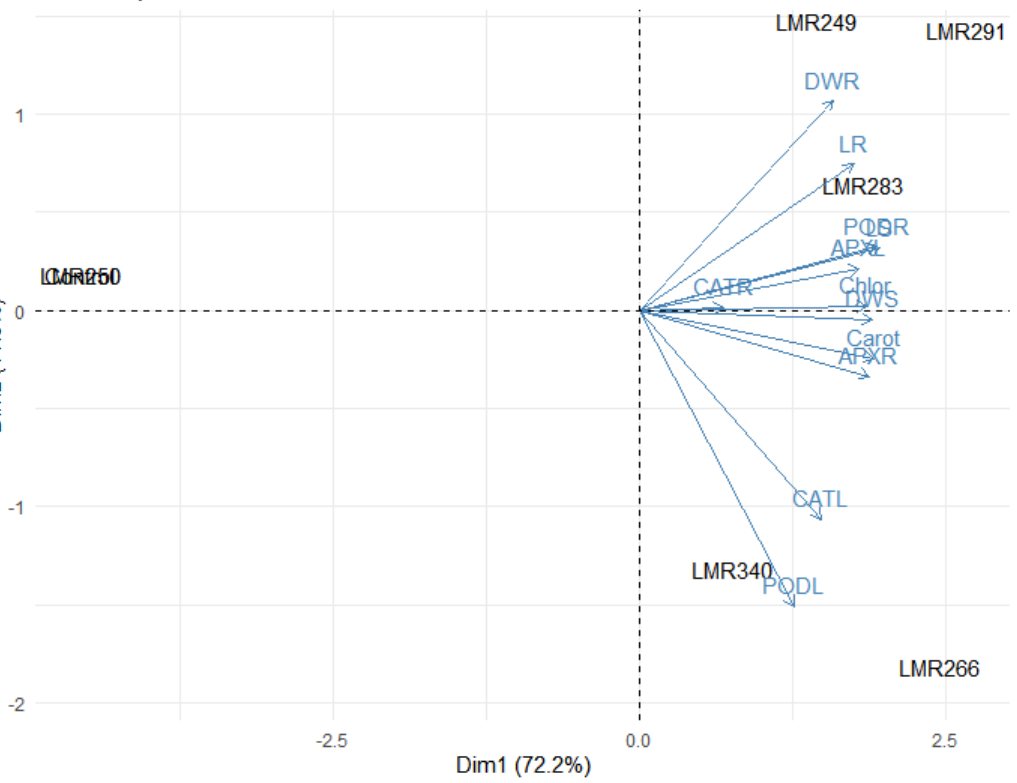
Figure 8. The correlation biplot between the Dim1 and Dim2 showed the 83.7% variation in which Dim 2 contributed 11.5% and Dim 1 contributed 72.2%. Strongly and positively correlated variables were very close to each other and present in the same quadrat. The blue color showed correlation between parameters (LS, LR, DWS, DWR, Chlor, Carot, PODL, PODR, APXL, APXR, CATL, CATR) while the black color showed correlation within treatments (Control, LMR249, LMR250, LMR266, LMR283, LMR291, LMR340). LS: Length of shoots, LR: Length of roots, DWS: Dry weight of shoots, DWR: Dry weight of roots, Chlor: Total chlorophyll, Carot: Carotenoids, PODL: POD of leaves, PODR: POD of roots, APXL: APX of leaves, APXR: APX of roots, CATL: CAT of leaves, CATR: CAT of roots.